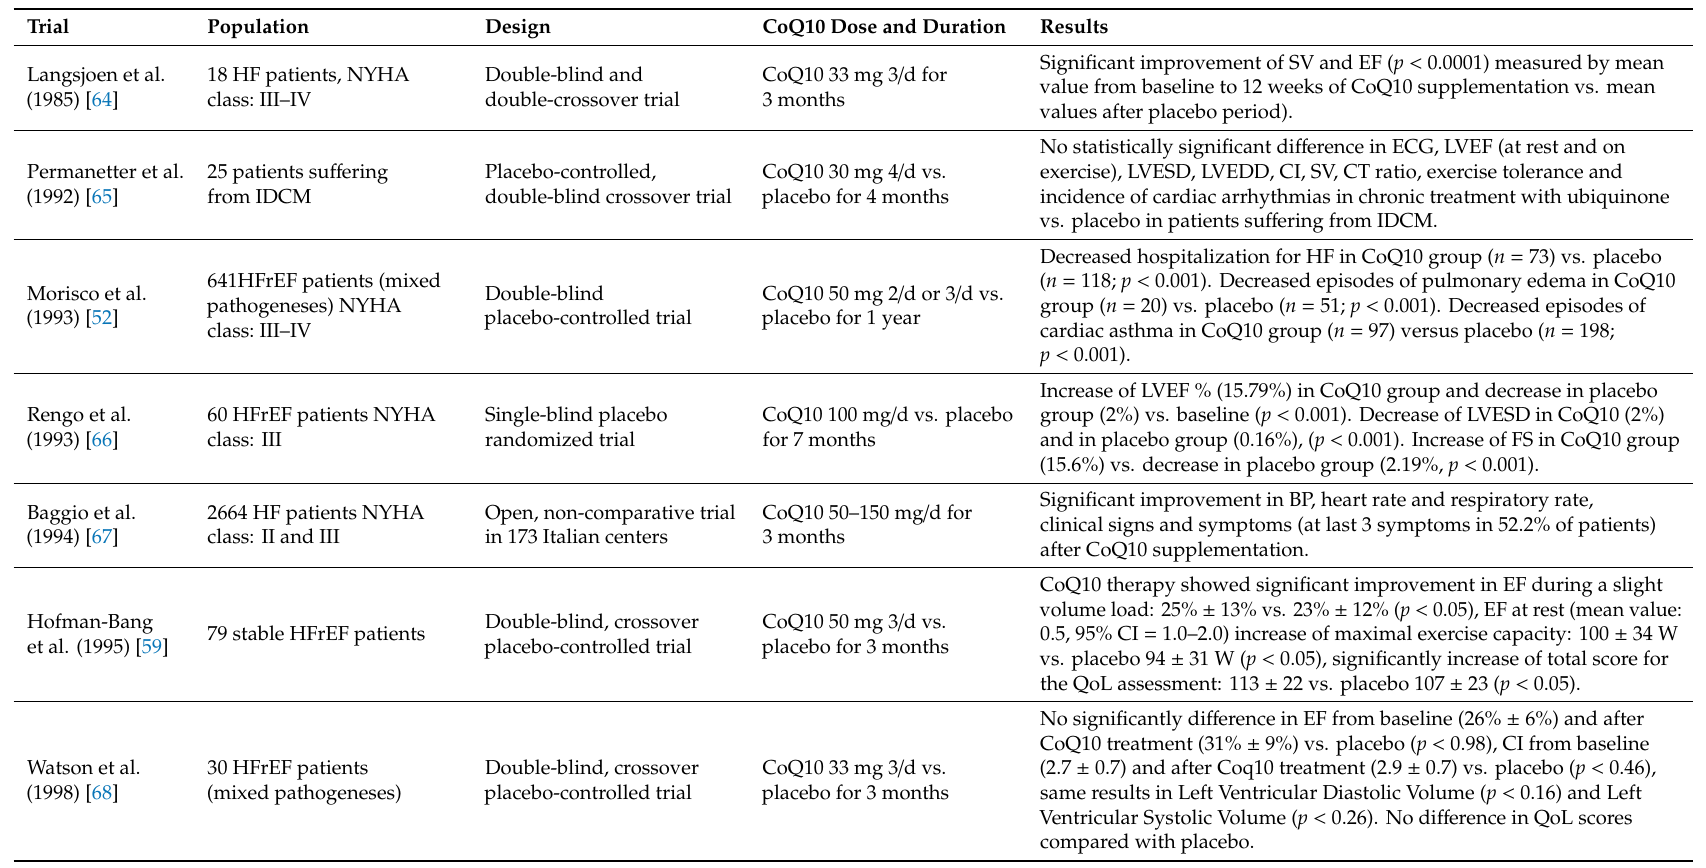
Table 1. Clinical